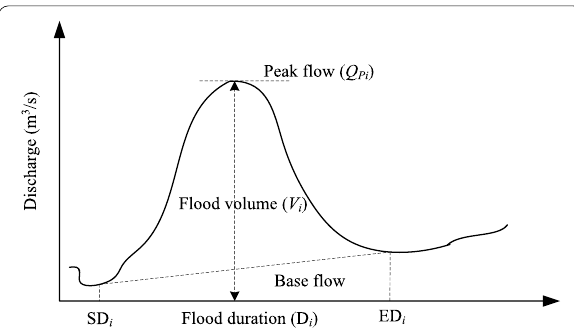
Fig. 2 Typical flood hydrograph showing flood flow characteristics (adapted from Ganguli and Reddy